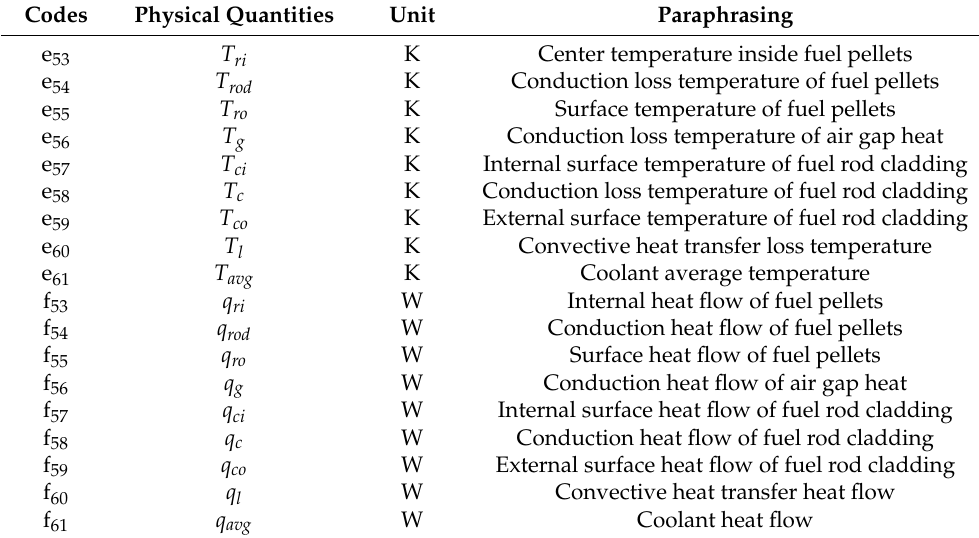
Table 4. The meaning of physical quantities shown in Figure